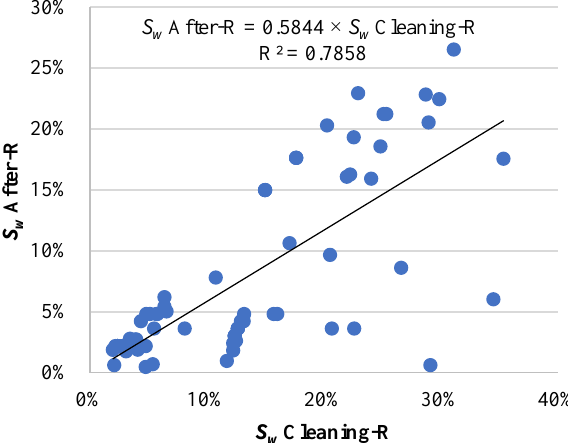
Figure 10. Correlation between the effects of S w cleaning and S w after on renderings.